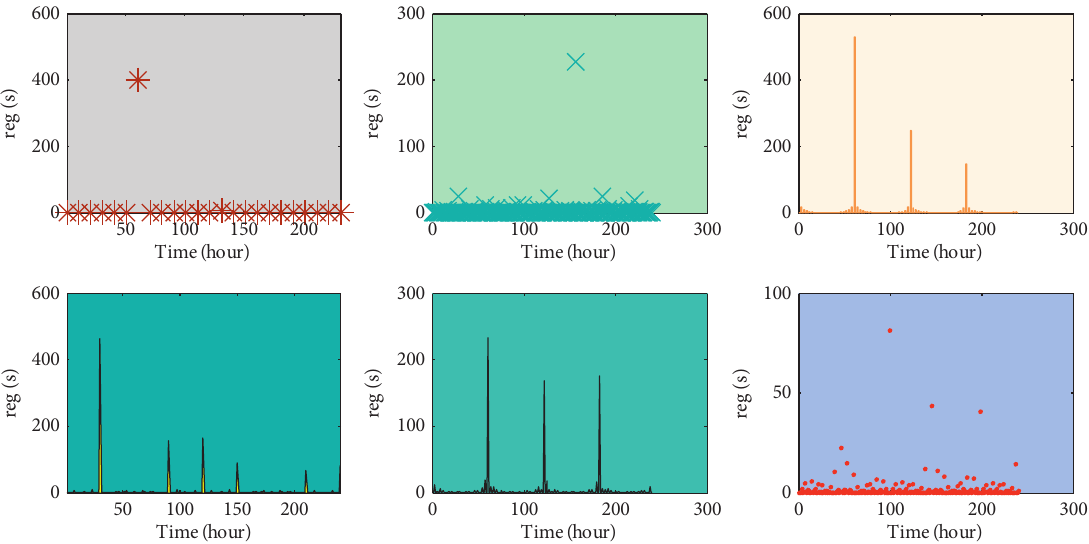
Figure 6: The load effect diagram generated by the 6 load generators in the experiment.